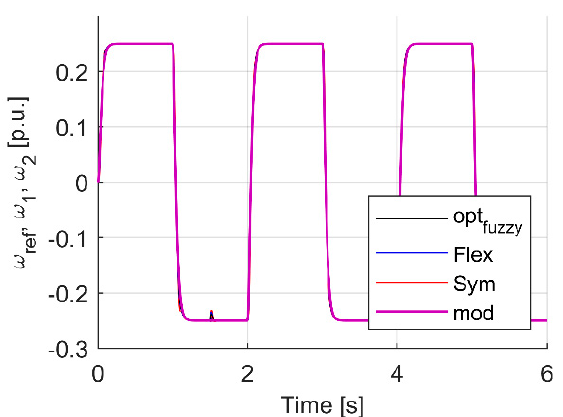
Figure 7. Transients of difference between motor and reference speed for analyzed controller cases.